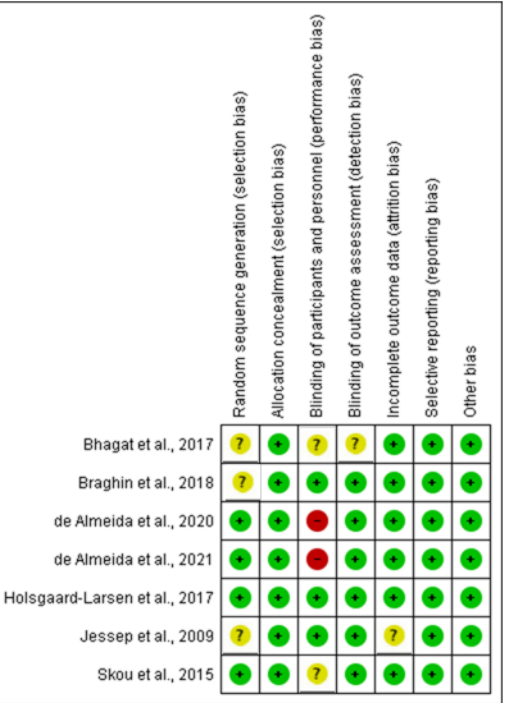
Figure 2. Risk of bias graph: review authors’ judgments about each risk of bias item presented as percentages across all included studies.